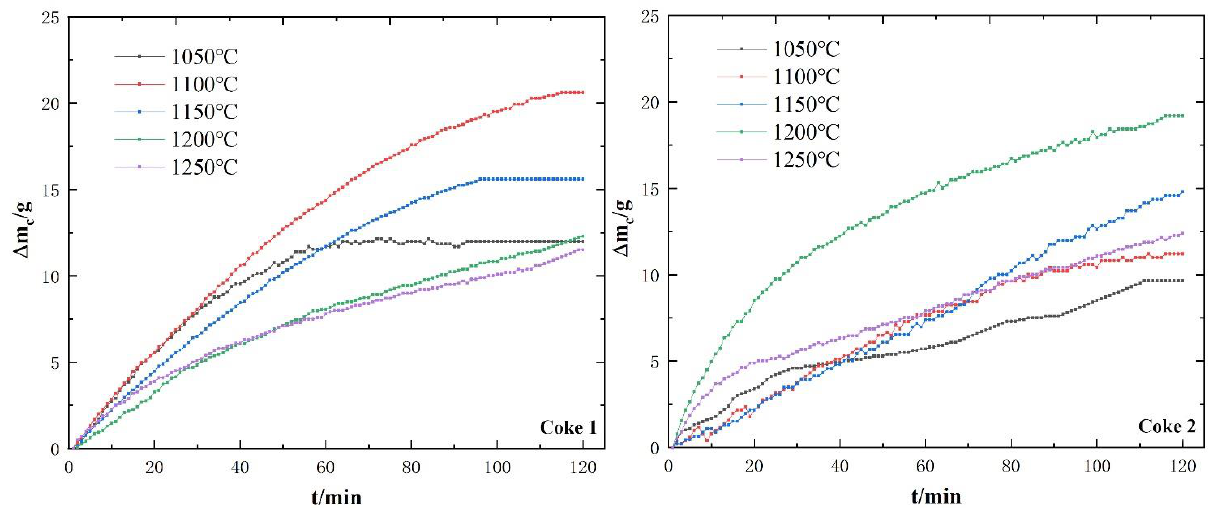
Figure 7. Weight loss curve of coke during the dissolution loss reaction.